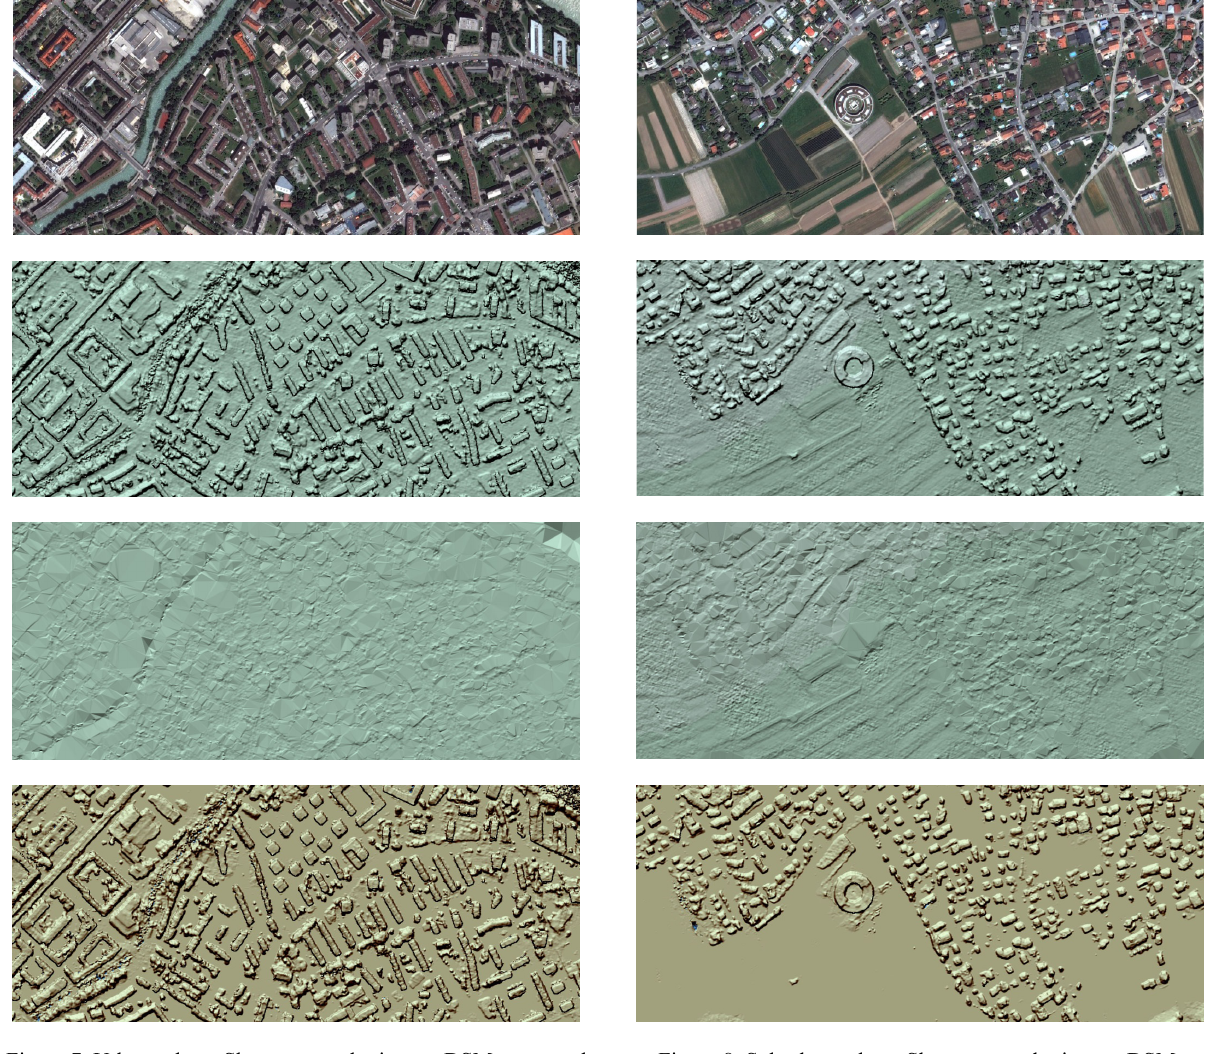
Figure 7. Urban subset. Shown are ortho image, DSM, extracted DTM and corresponding nDSM.